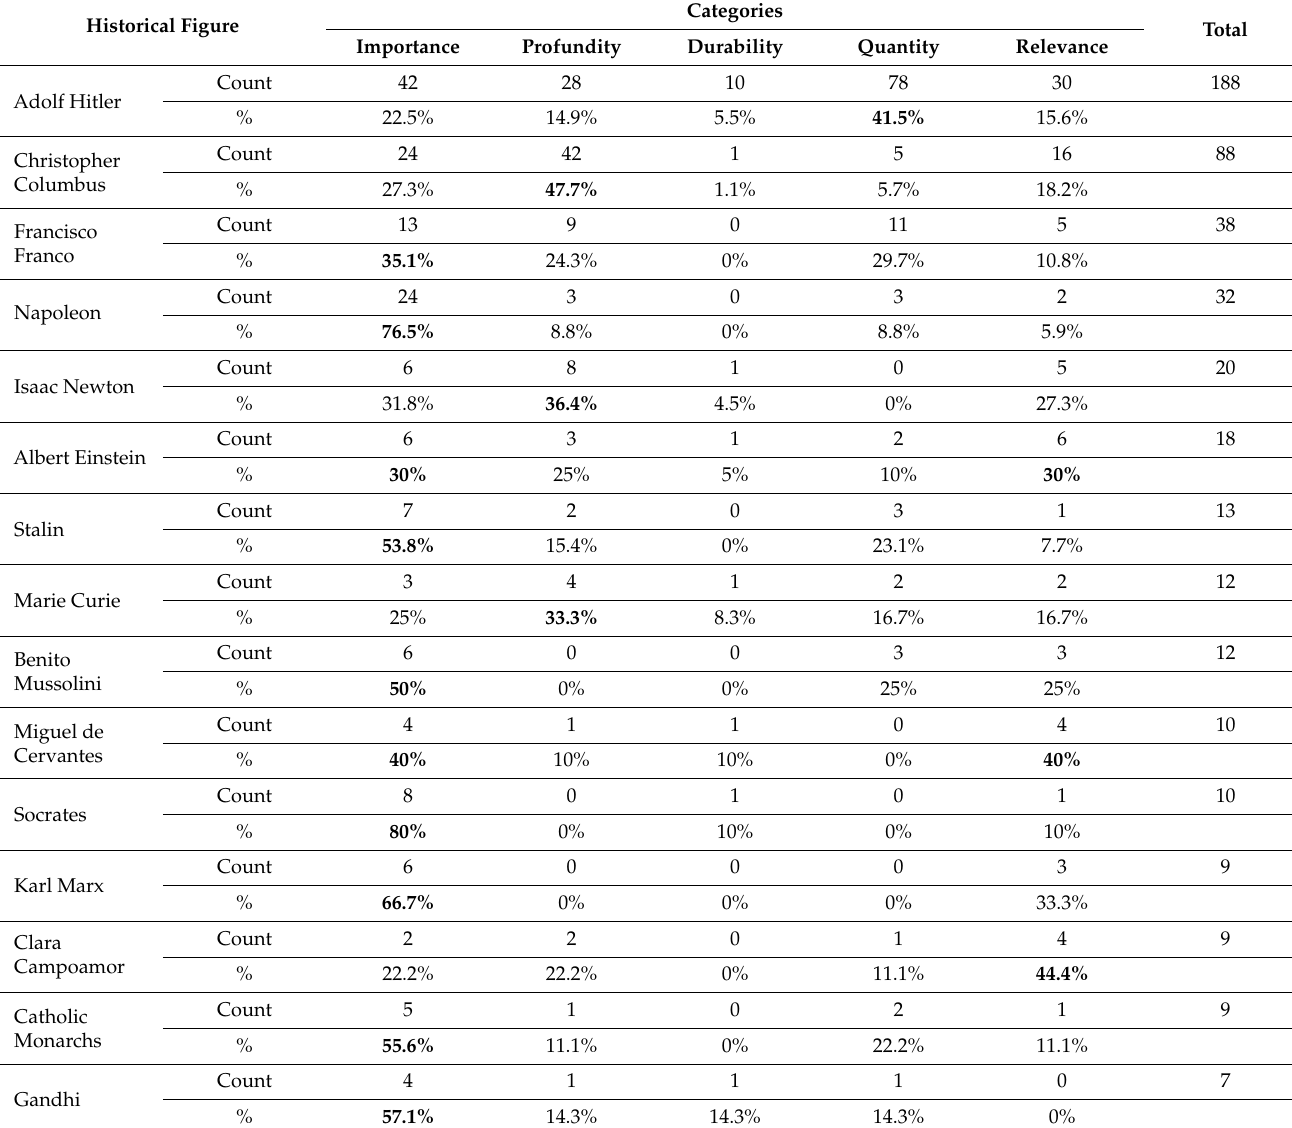
Table 5. Most mentioned figures and the level of historical significance